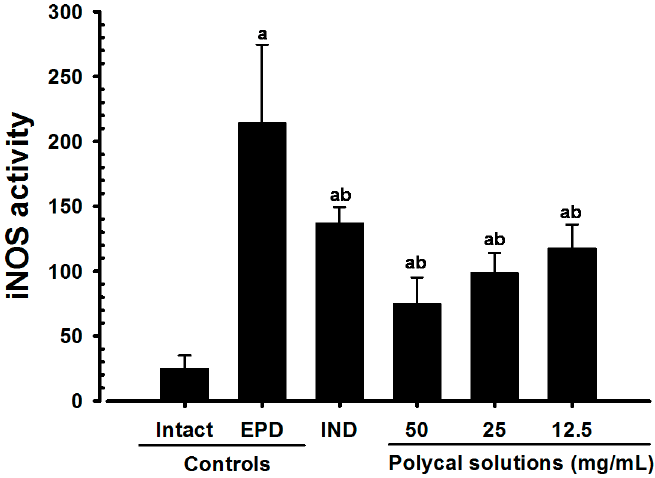
Figure 8. Gingival iNOS activities in Intact or EPD rats. Values are expressed mean ± S.D. of eight rats, fM/mg tissue/min. EPD = experimental periodontal diseases induced by ligature placement around the cervix of upper left incisor teeth; Polycal = Polycan and calcium gluconate 2:98 (g/g) mixture, which was topically applied to ligated gingival regions, once a day for 10 days (200 μ L/rats); IND = Indomethacin, which was orally administered at 5 mg/kg dose level, once a day for 10 days; iNOS = Inducible nitric oxide synthase. a p < 0.01 as compared with Intact control; b p < 0.01 as compared with EPD control.